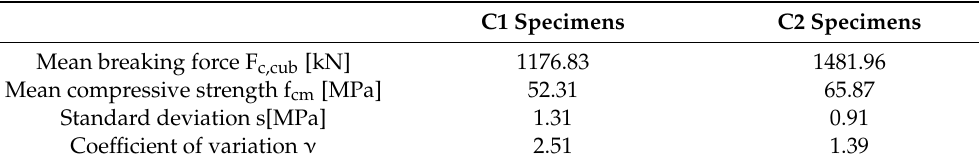
Figure 12. Charts of compressive strength tests of the specimens. Table 4. Results of compressive strength tests of concrete for C1 and C2 specimens.